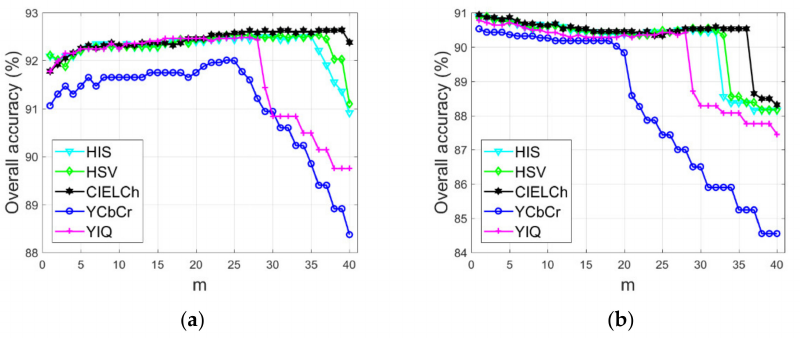
Figure 9. The sensitivity of the LSI algorithm to the neighborhood parameter m for test images. ( a ) Tripoli-1. ( b ) Tripoli-2.